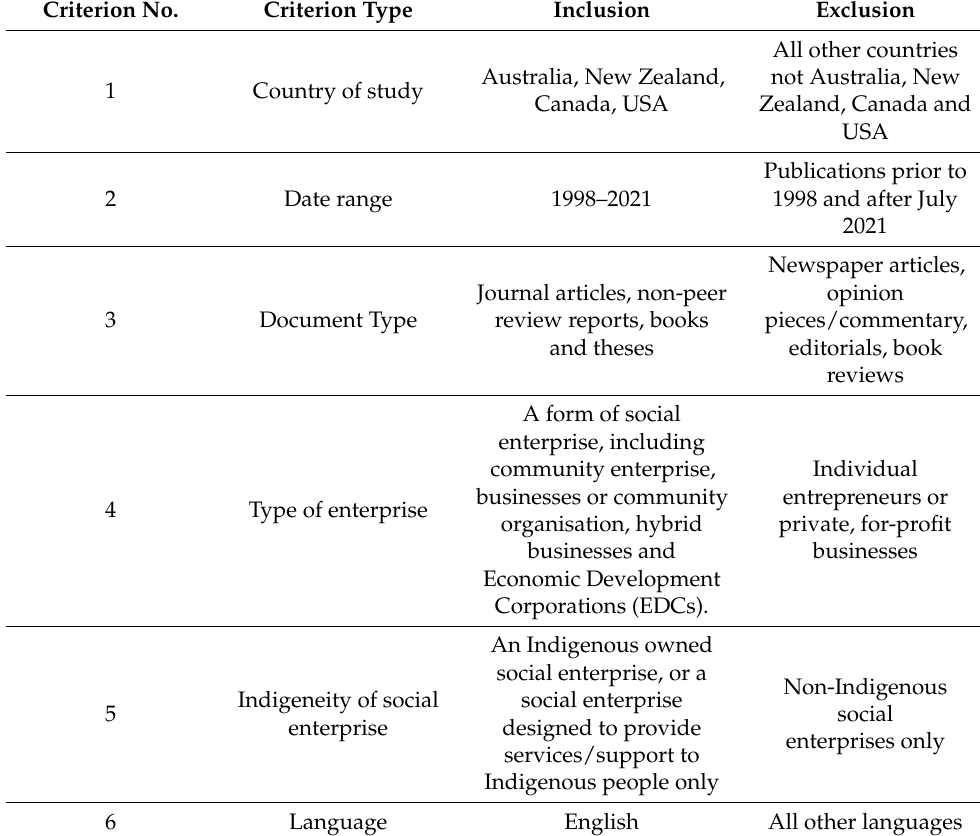
Table 1. Inclusion and exclusion criteria of scoping